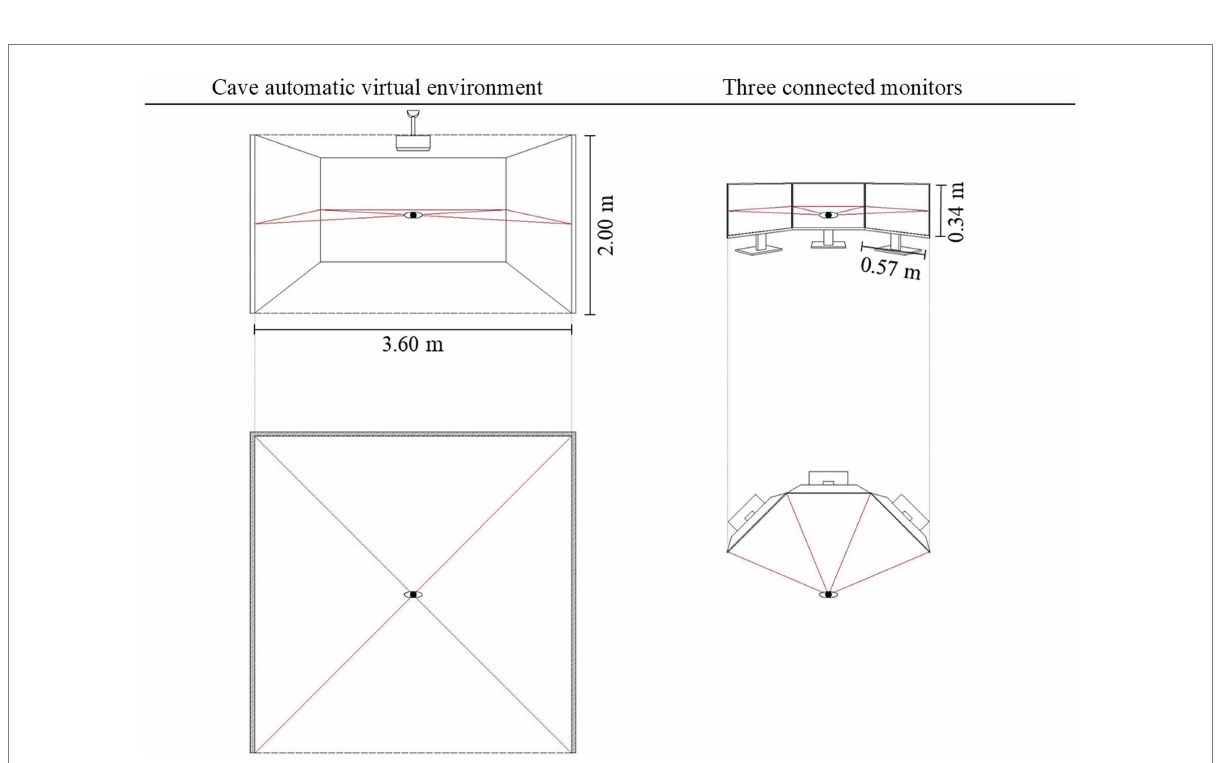
FIGURE 3 Schematic diagram of the experimental setup and representation